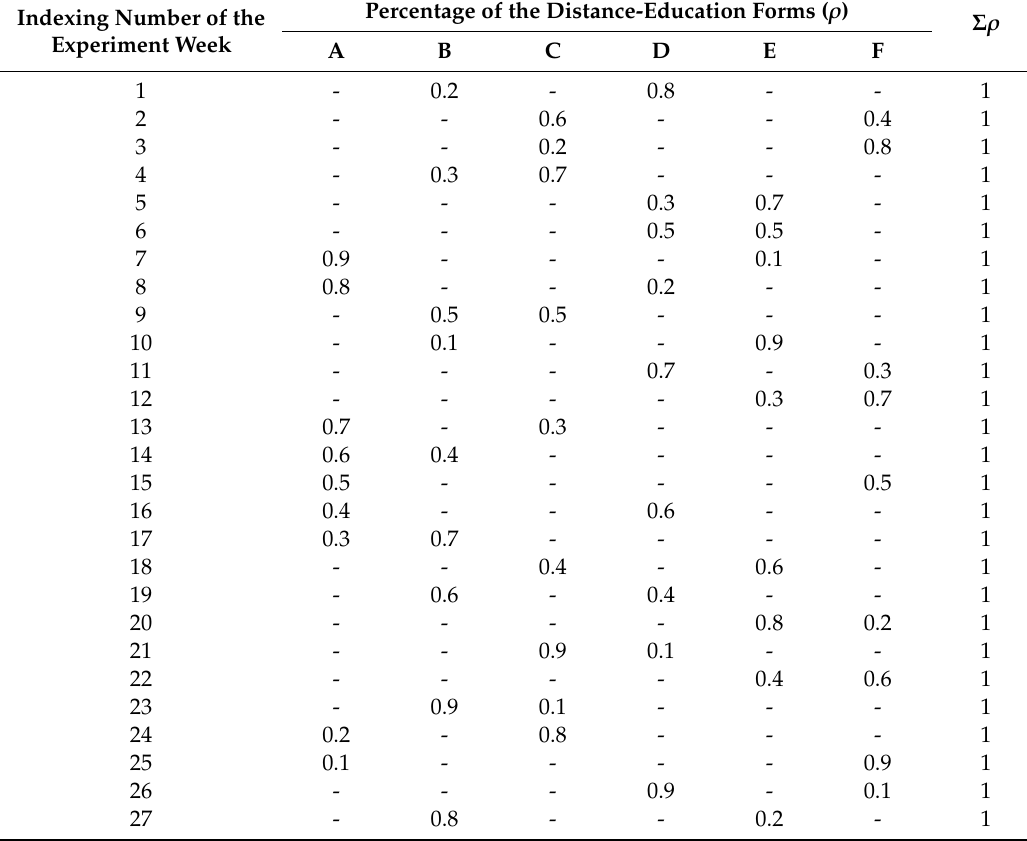
Table A5. Schedule for conducting an experiment to improve the distance-learning e ff ectiveness at the university: a case study of learning the discipline “Theoretical